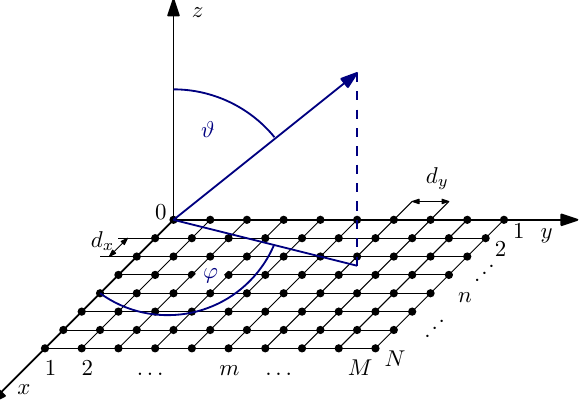
Figure 4. Planar antenna array with N × M